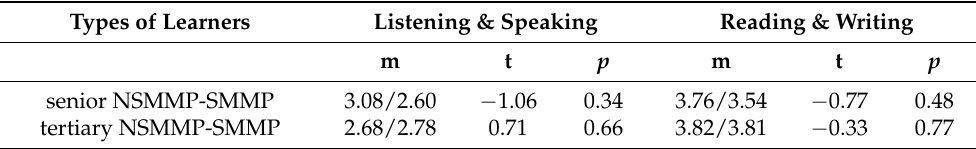
Table 1. Results of learners’ early stage language abilities.